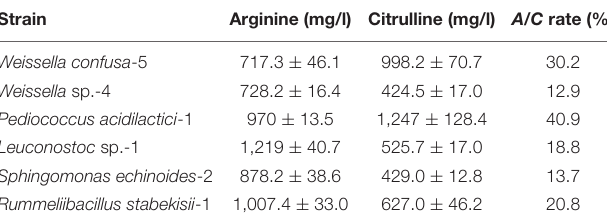
TABLE 1 | The arginine consumption and citrulline accumulation ability of crucial bacteria in modified MRS broth.